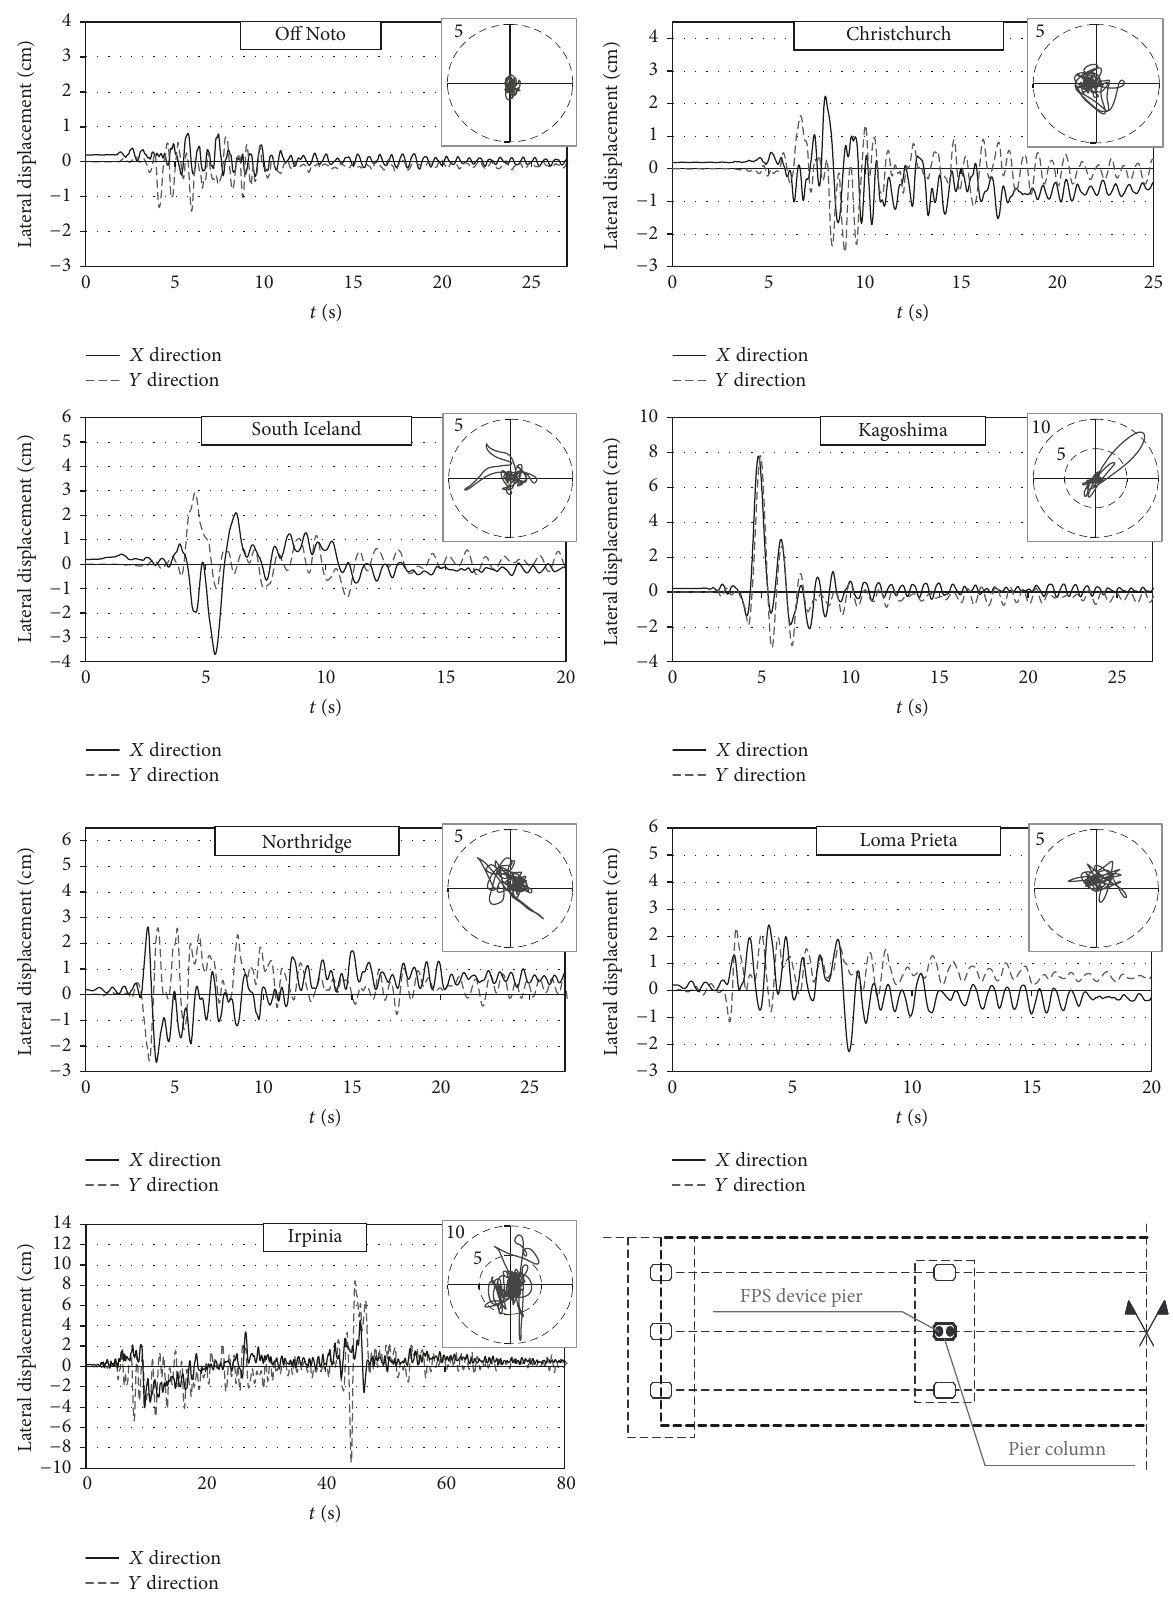
Figure 13: Seismic response of the FPD isolators placed at the top of pier internal column for earthquake along the transverse